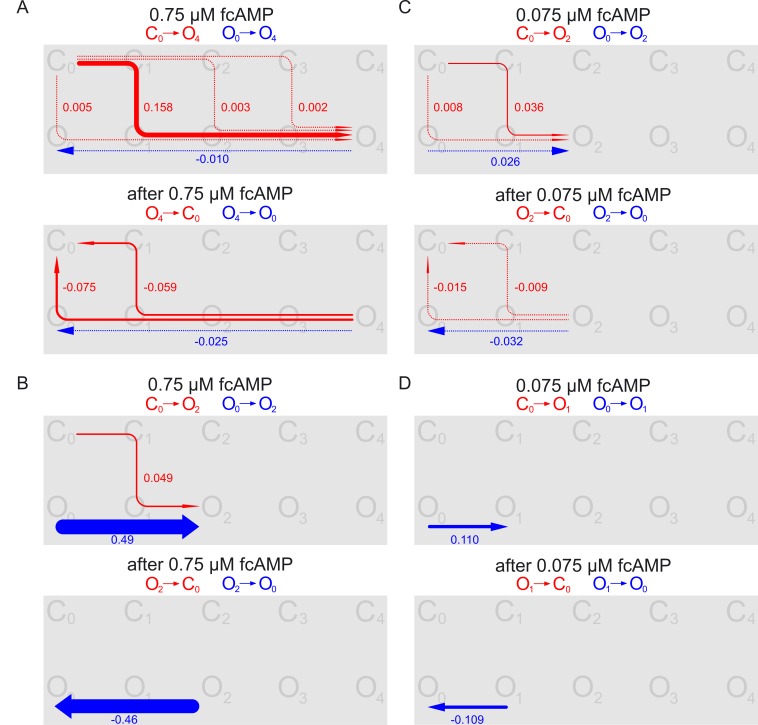
Transition pathways in the C4L-O4L model at subsaturating fcAMP.The illustration is analogous to Fig. 4. The two main net probability fluxes at each concentration are shown. Pathway net probability fluxes associated with activation (C
0→O
x, O
0→O
x) and deactivation (C
x→O
0, O
x→O
0) are shown in red and blue color, respectively. (A) 0.75 µM fcAMP, C
0↔O
4. (B) 0.75 µM fcAMP, net probability flux along C
0↔O
2 in addition to that included in C
0↔O
4. (C) 0.075 µM fcAMP, C
0↔O
2. (D) 0.075 µM fcAMP, net probability flux along C
0↔O
1 in addition to that included in C
0↔O
2.